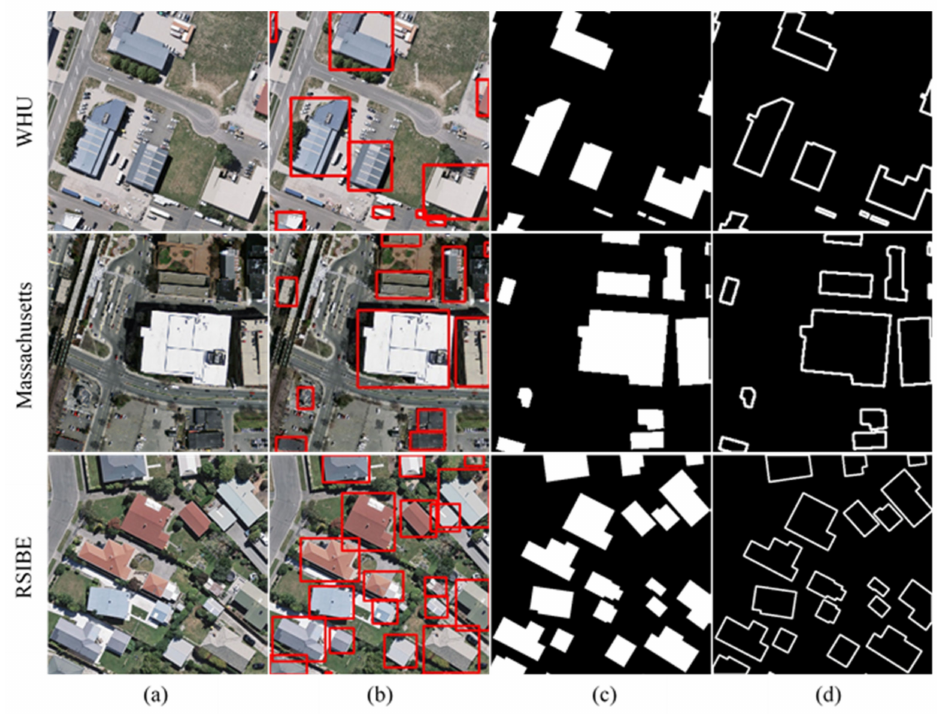
Figure 5. Examples of the experimental datasets. ( a ) Images. ( b ) Building detection labels. ( c ) Building footprint segmentation labels. ( d ) Building edge extraction